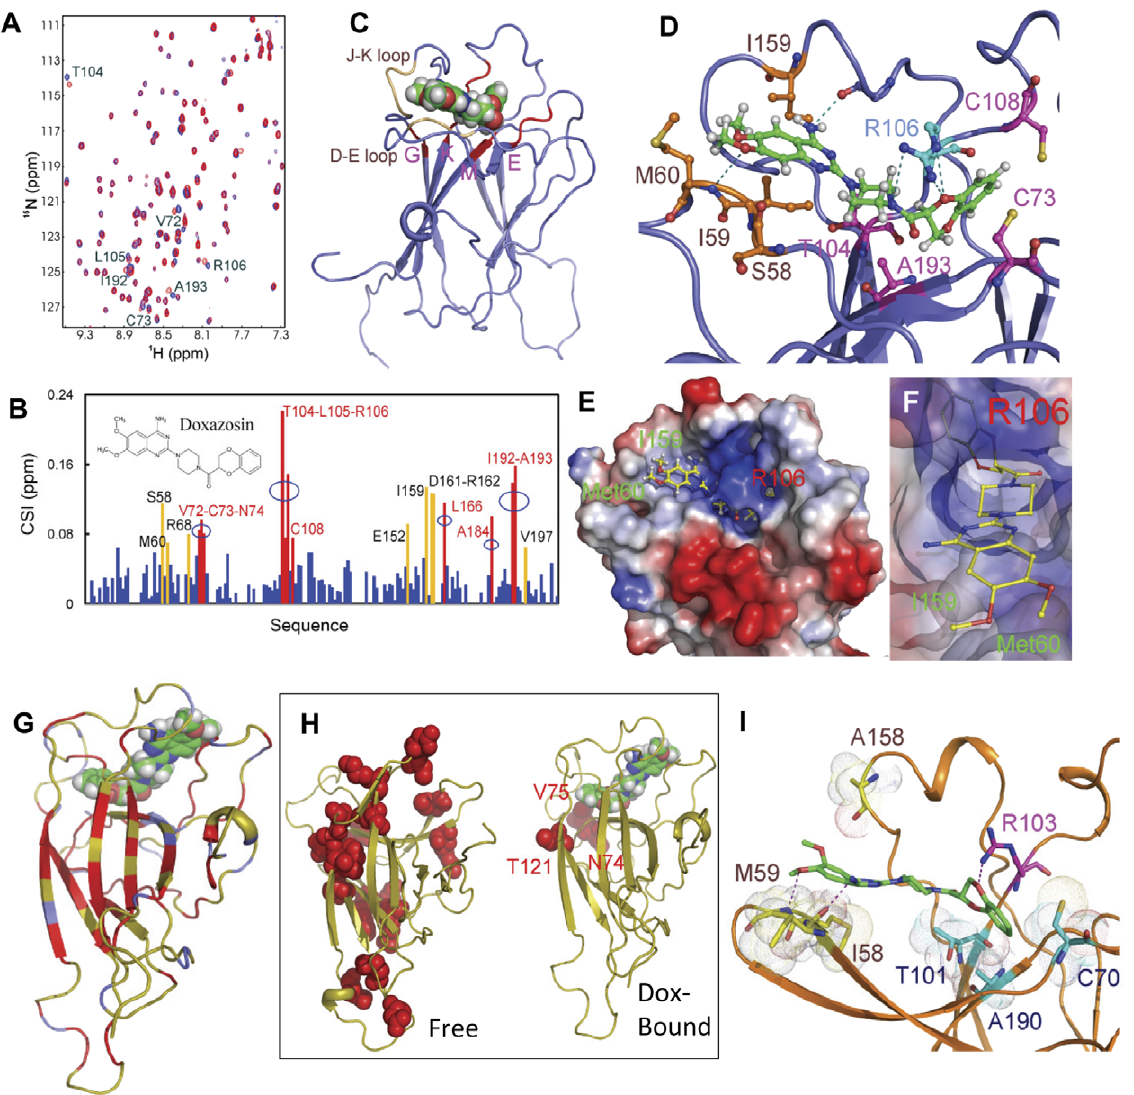
Figure 3. Structure and dynamics of the EphA4-doxazosin complex. (A) 1 H- 15 N NMR HSQC spectra of the EphA4 LBD in the absence (blue) and in the presence (red) of doxazosin (DZ) at a molar ratio of 1:5 (EphA4:DZ). Several residues located over the convex surface of the EphA4 ephrin- binding channel are labeled. (B) Residue-specific chemical shift index (CSI) of the EphA4 LBD in the presence of doxazosin at a molar ratio of 1:5 (EphA4:DZ). Significantly-shifted residues shared with C1 are colored in bright brown, while the residues significantly shifted only by doxazosin binding are in red. (C) The docking model of the EphA4-doxazosin complex in ribbon. Binding regions identical to those for the C1-binding were colored in brown, while those unique for the doxazosin binding in red. G, K, M and E are used to donate b -strands of the convex surface of EphA4/ ephrin-binding channel. (D) EphA4 residues having direct contacts with doxazosin. Residues on D–E and J–K loops are in brown, those on the convex surface in violet, and Arg106 in cyan. Green dashed lines indicate hydrogen bonds between doxazosin and EphA4 residues. (E)–(F) The same docking model with the electrostatic potential of the EphA4 LBD displayed. (G) EphA4 LBD in free and doxazosin-bound states display different squared generalized order parameter S 2 (Figure S6A). Blue: S 2 difference #2 0.01; red: S 2 difference $ 0.01; brown: no significant change or S 2 values not determined. (H) Conformational exchanges of EphA4 in free (left panel) and doxazosin-bound states (right panel). Residues with R ex . 5 (Figure S6B) are displayed in balls and colored in red. (I) A docking model of the EphA2-doxazosin complex. Contact residues in D–E and J–K loops are labeled in brown, on the convex surface in cyan, and Arg103 in violet. The violet dash is used to indicate the hydrogen bonds between doxazosin and EphA2